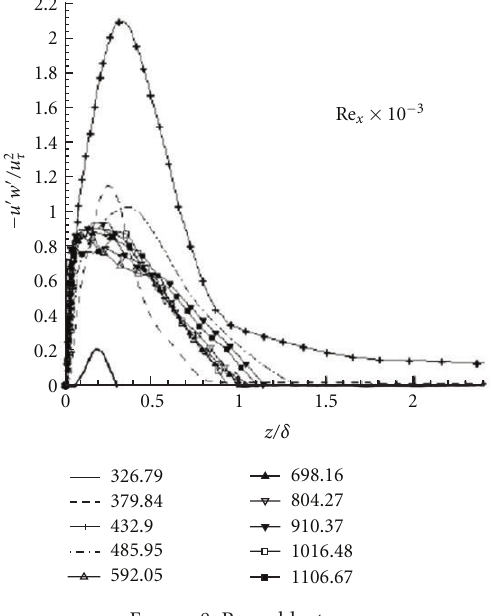
Figure 8: Reynolds stress.